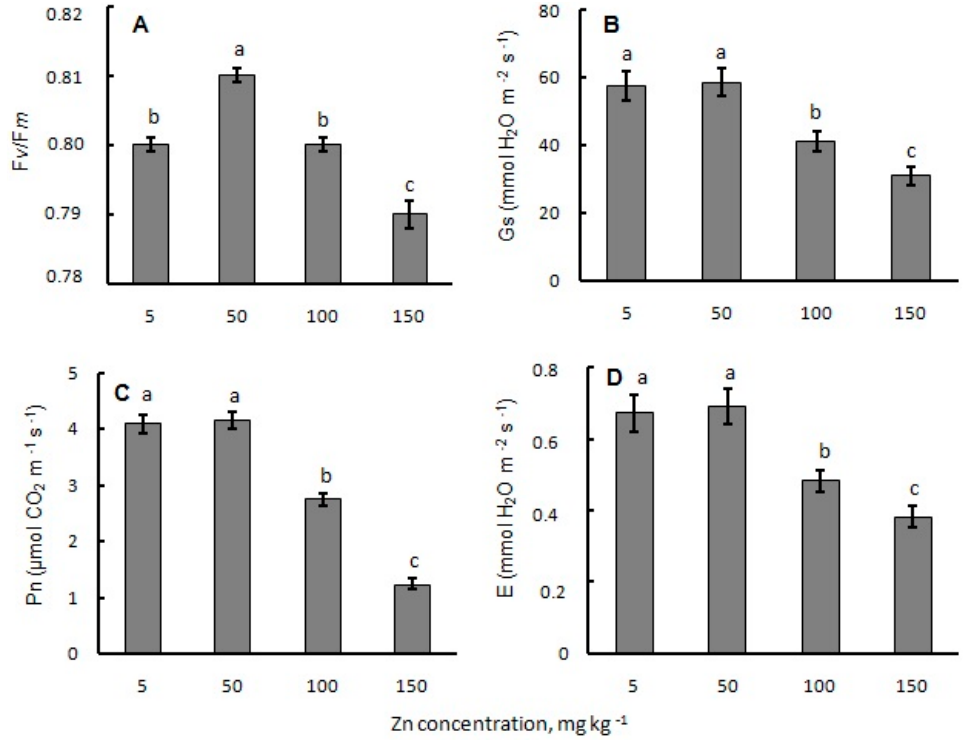
Figure 1. Effect of Zn excess in substrate on ( A ) maximum efficiency of PSII photochemistry (F v /F m ), ( B ) stomatal conductance (Gs), ( C ) net photosynthetic rate (Pn), and ( D ) transpiration rate of white mustard plants. Data are represented as mean ± SE ( n = 18). Data followed by the same letter are not significantly different at p < 0.05 (ANOVA).